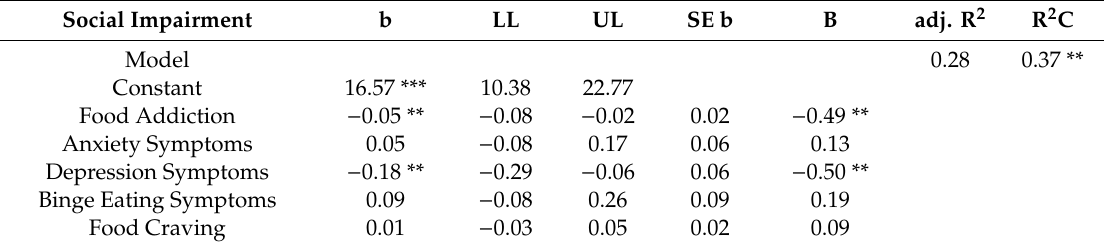
Table 5. Multiple regression results predicting social impairments measured using WHOQOL-bref.